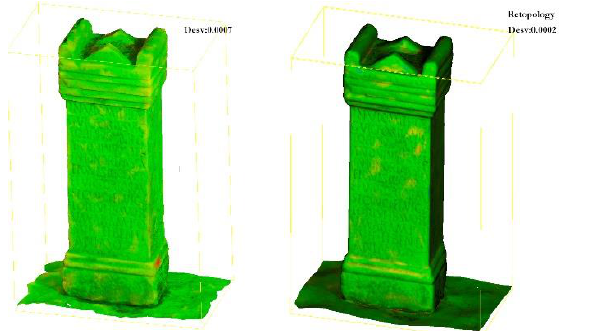
Figure 5. Model 4k from Capture Reality on left and model retopology on